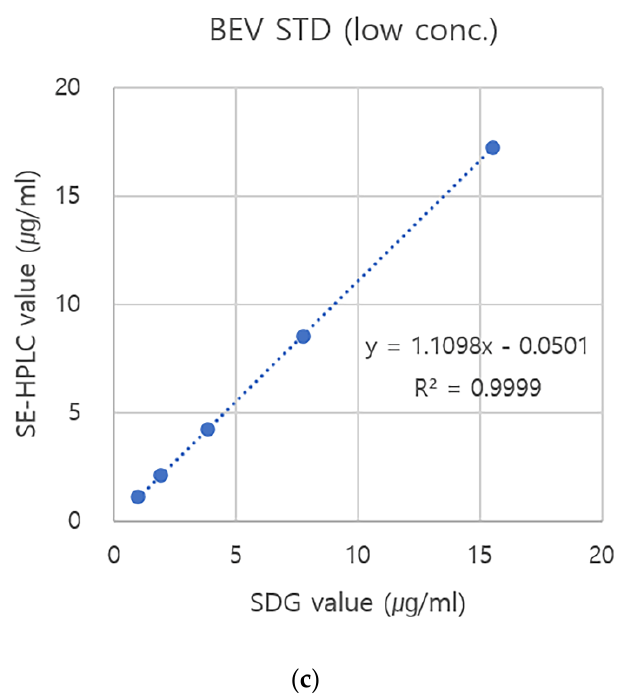
Figure 6. BEV standard curves showing correlation between the quantitation value of SE-HPLC and that of SDG. ( a ) A BEV standard curve at high concentration used in adjustment of FMD vaccine antigen content at a high concentration of FMDV pure antigens. ( b ) A BEV standard curve at low concentration used in adjustment of FMD vaccine antigen content at a low concentration of FMDV pure antigens. ( c ) A BEV standard curve at low concentration used in adjustment of FMD vaccine antigen content in a crude virus infection supernatant. Abbreviations: BEV, bovine enterovirus; STD, standard; SDG, sucrose density gradient ultracentrifugation; SE-HPLC, size-exclusion high- performance liquid chromatography.